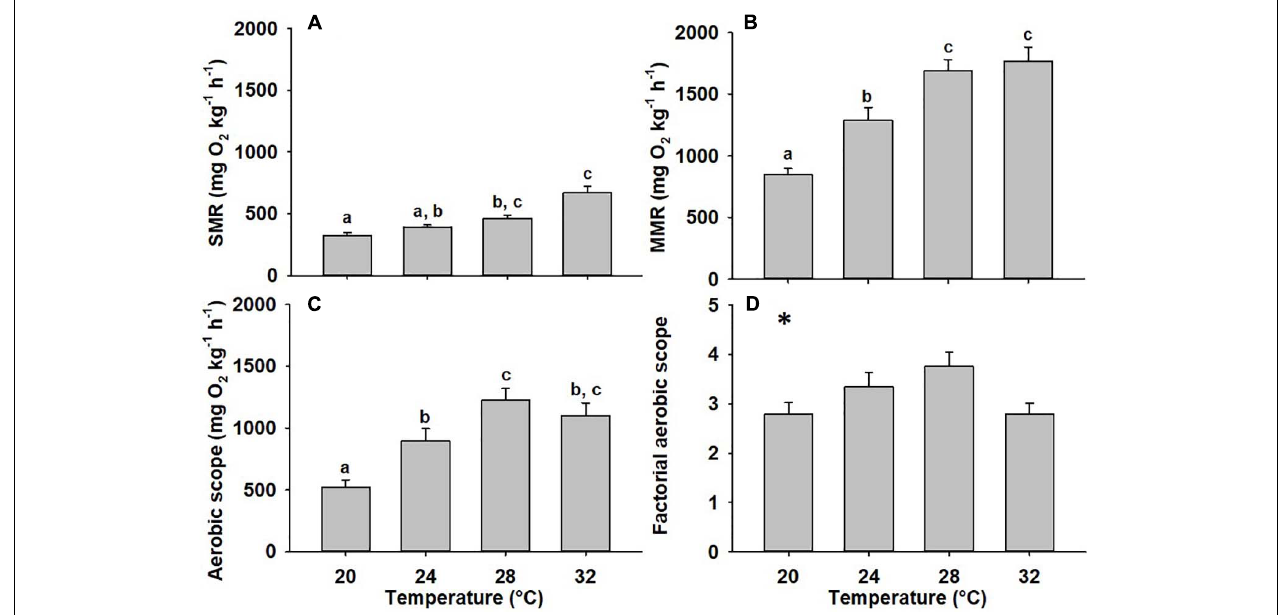
FIGURE 1 | Metabolic rates of mahi acclimated to different temperatures. Standard metabolic rate (SMR) (A) , Maximum metabolic rate (MMR) (B) aerobic scope (C) , and factorial aerobic scope (D) of mahi acclimated to 20, 24, 28, or 32 ◦ C ( n = 16, 14, 14, 13, respectively). Data were normalized for body mass by scaling SMR and MMR values predicted for a 40 g fish (aerobic scope = normalized MMR-normalized SMR, SMR = 0.6088, MMR = 0.7936) (Stieglitz et al., 2016). Different lowercase letters denote statistical significance ( p < 0.05) between temperatures performed using post hoc pair-wise comparisons. An asterisk denotes statistical significance in the ANOVA with no statistically significant comparisons evident in post hoc comparisons. Values represent means ±